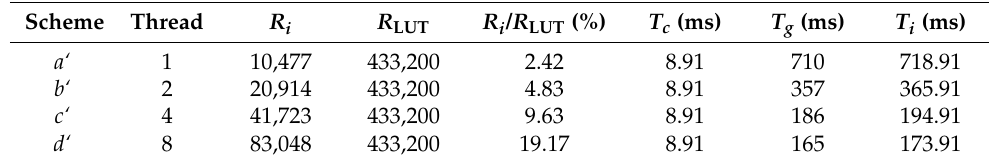
Table 6. Test results of interferogram generation with different threads.